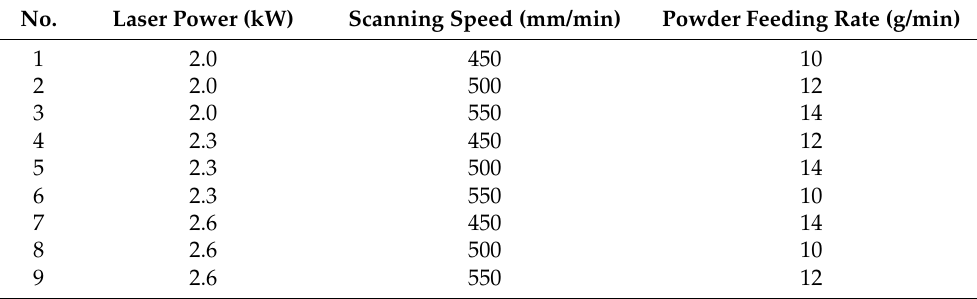
Table 4. Orthogonal process parameters.